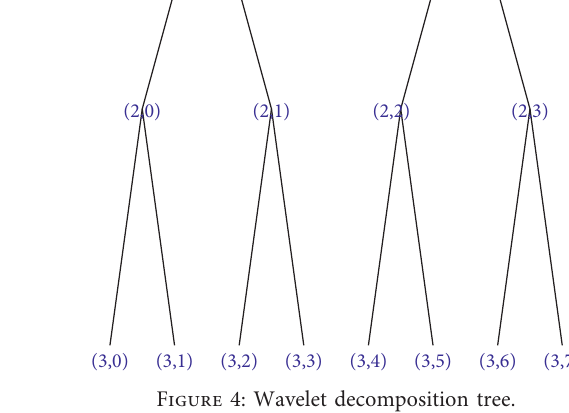
Figure 4: Wavelet decomposition